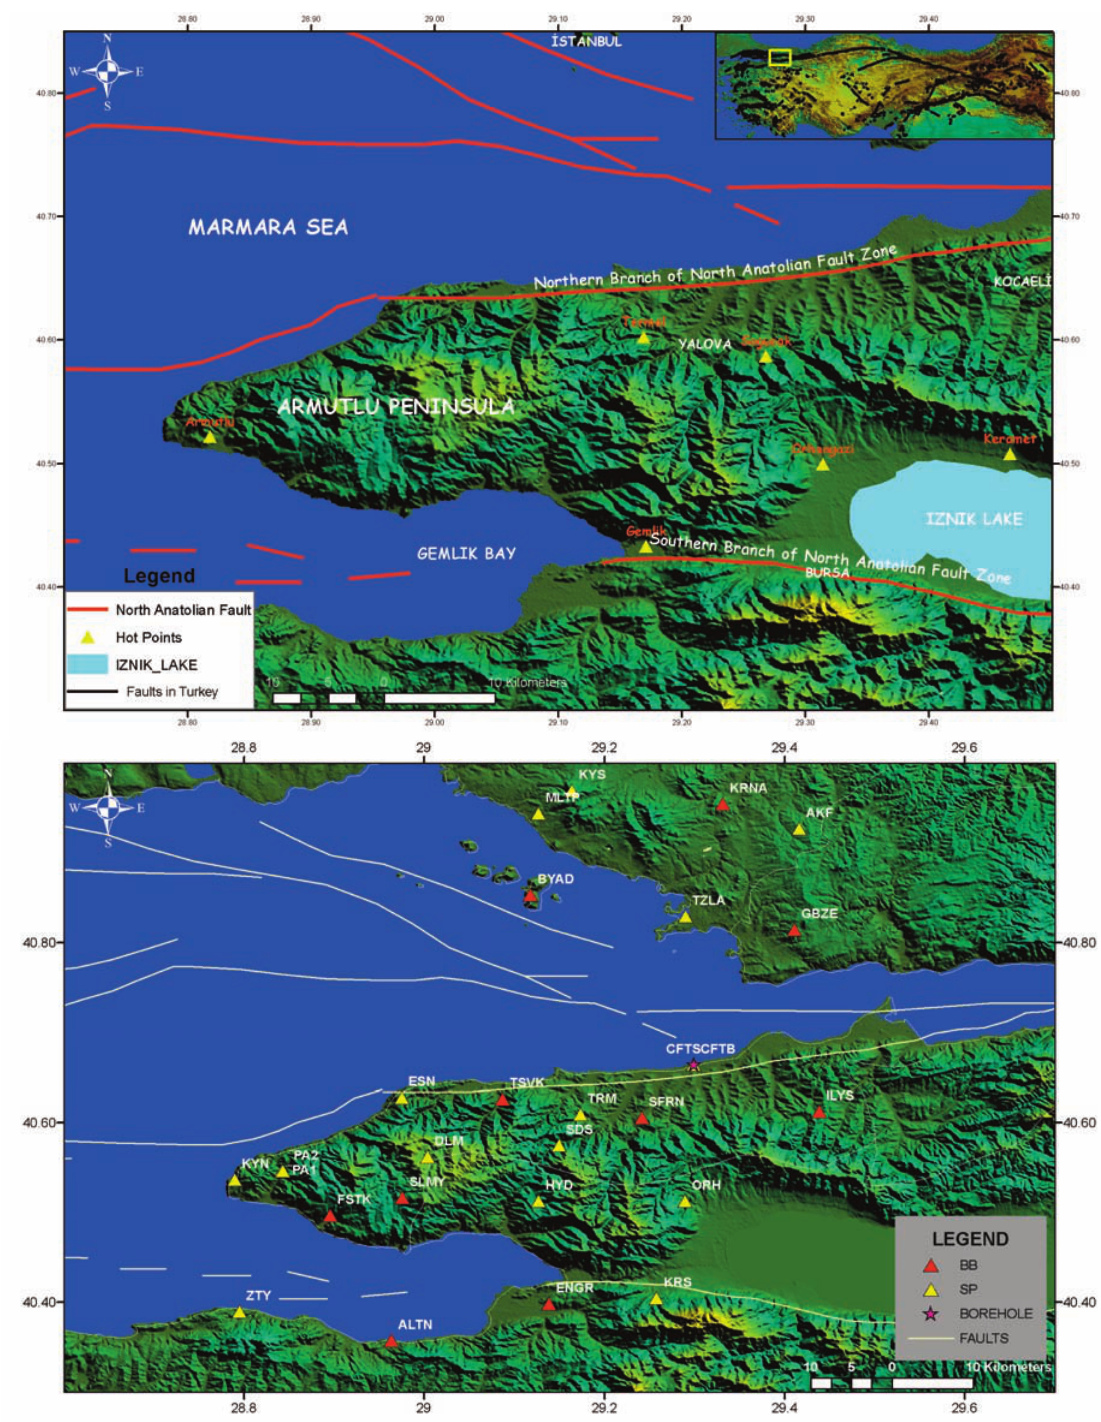
Figure 1 (top). The location of the Armutlu Peninsula. Figure 2 (bottom). Distribution of the ARNET stations. Red triangles, broad-band seismic stations; yellow triangles, short-period seismic stations; red star, borehole station; white lines, proposed active